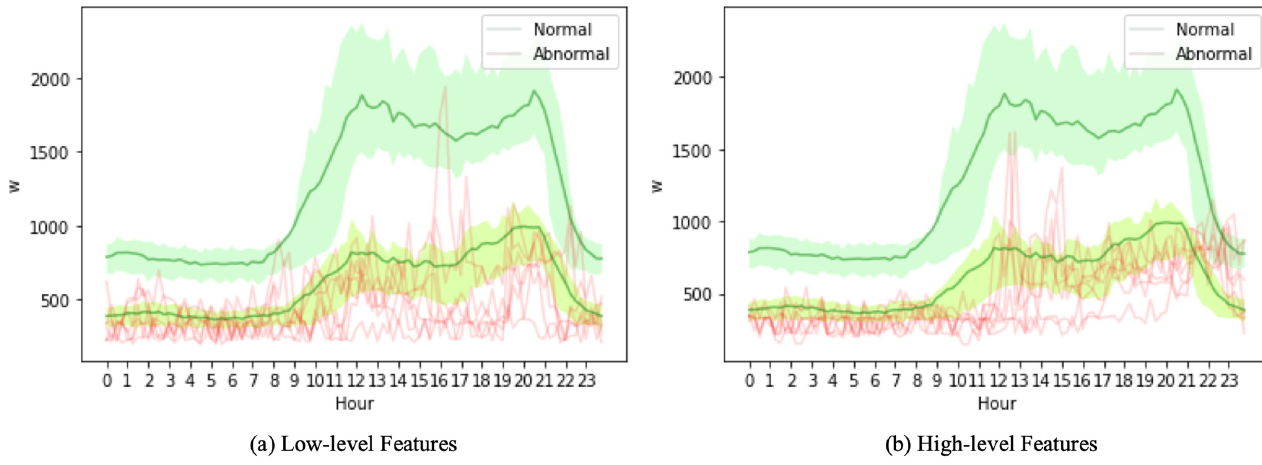
Figure 9. Load profiles of the main and abnormal electricity consumption events of User 05.